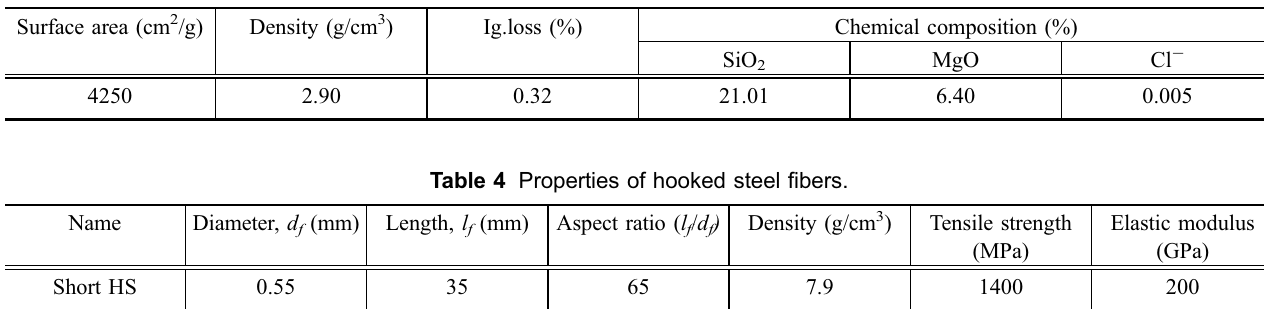
Table 3 Chemical compositions and physical properties of Type III blast furnace slag.